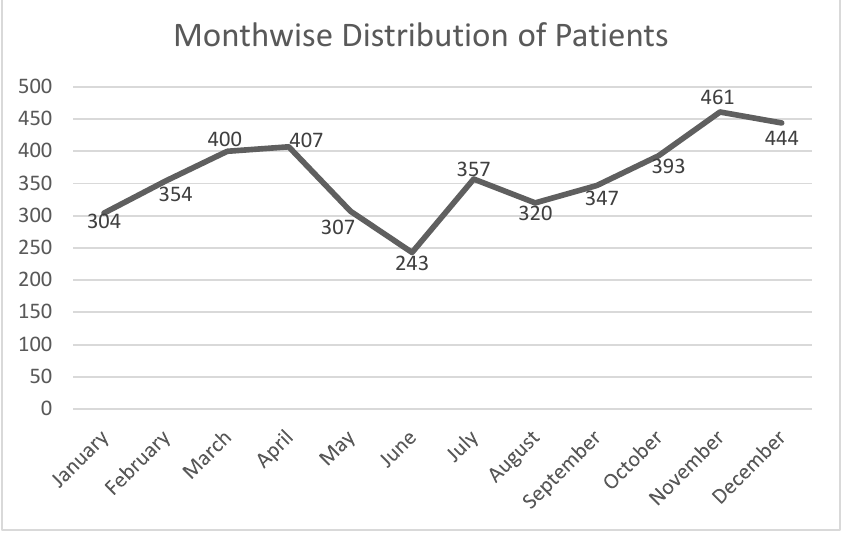
Figure 3. The month-wise analyses of the number of women visiting the screening center.